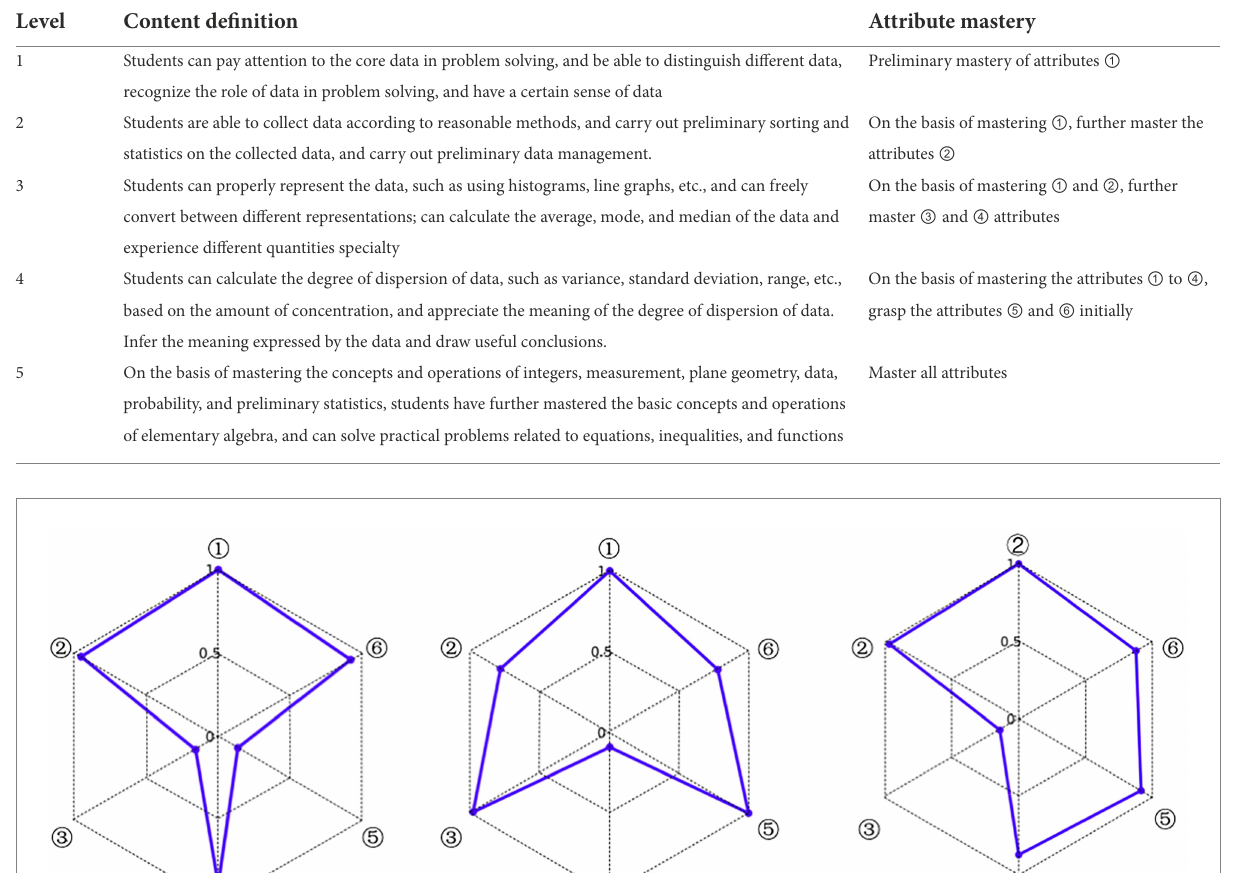
TABLE 7 Divisions of learning progression levels of data analysis ability.